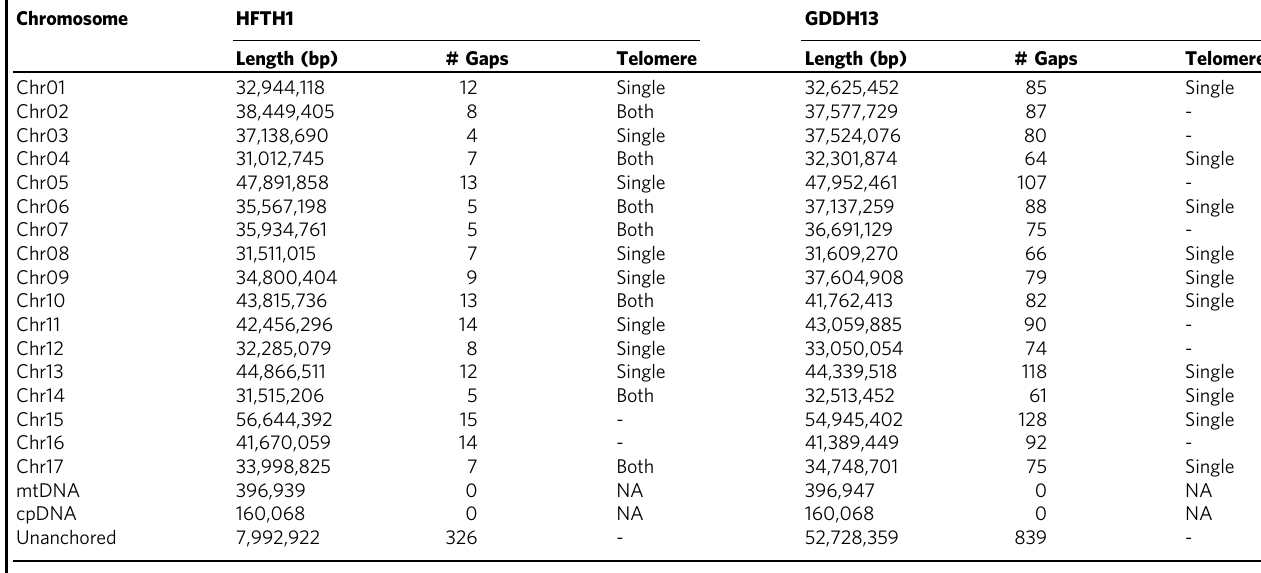
Table 1 Statistics of HFTH1 and GDDH13 genome assemblies